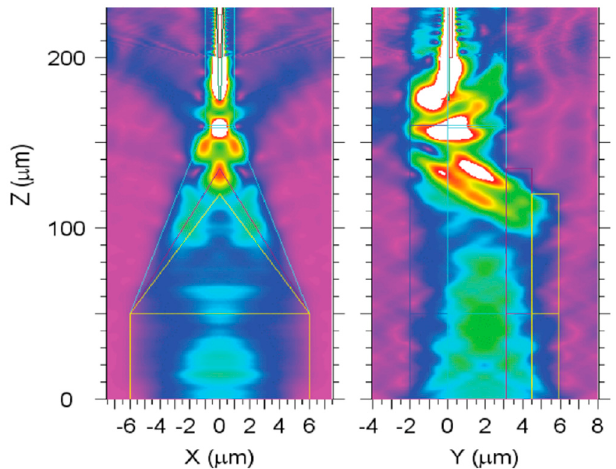
Figure 12. Simulated optical field distribution in a multi-stage edge coupler under the regime depicted in Figure 9b. ( Left ) top view and ( Right ) side view of modal distribution. Reproduced with permission from [82], Copyright IEEE, 2016.